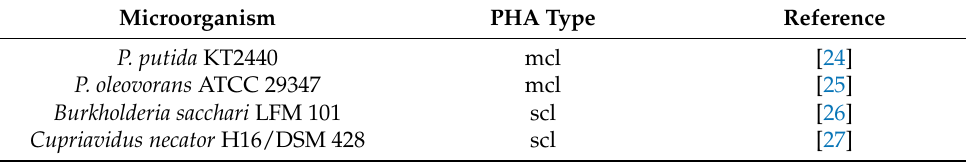
Figure 3. Biosynthesis pathways of short chain length (scl) PHA, medium chain length (mcl) PHA and short-medium-chain length (scl-mcl) PHA from sugars and oils. PhaA, β -ketothiolase; PhaB, NADPH-dependent acetoacetyl-CoA reductase; PhaC, PHA synthase; PhaG, 3-hydroxyacyl-ACP- CoA transferase; PhaJ, (R)-enoyl-CoA hydratase; FabD, malonyl-CoA-ACP transacylase; FabG, 3-ketoacyl-CoA reductase [19]. Table 1. Microorganisms extensively studied for their ability to accumulate PHA`.